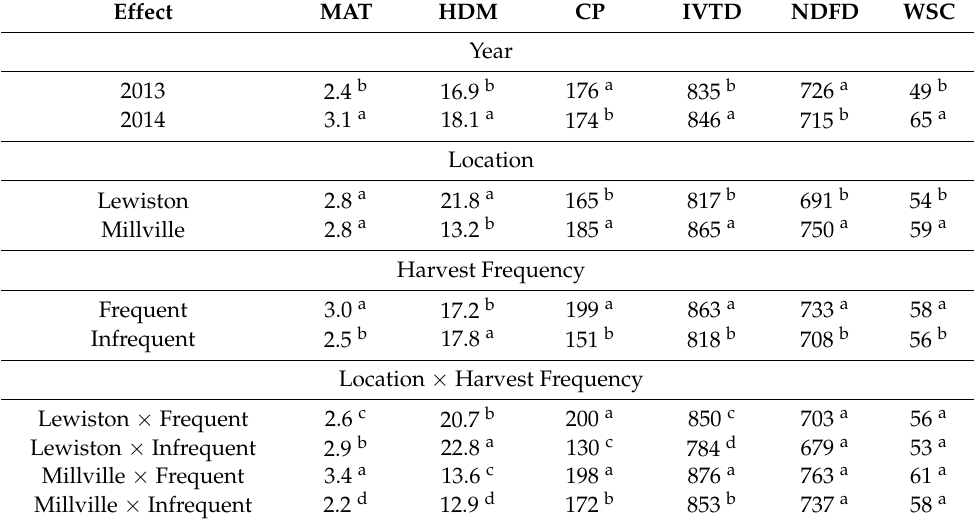
Table 2. Mean trait values corresponding to the main effects of year, location, and harvest frequency. Traits were maturity (MAT; 1—very late to 5—very early), herbage dry mass (HDM; Mg ha − 1 ), crude protein (CP; g kg − 1 ), in vitro true digestibility (IVTD; g kg − 1 ), neutral detergent fiber digestibility (NDFD; g kg − 1 ), and water-soluble carbohydrates (WSC; g kg − 1 ) and were measured on 58 orchard- grass families and three commercial cultivars during 2013 and 2014 at Lewiston and Millville, UT, under frequent and infrequent harvest intervals. Values in the same column and for the same effect followed by different letters differ at least at the 5% α level. Effect MAT HDM CP IVTD NDFD WSC